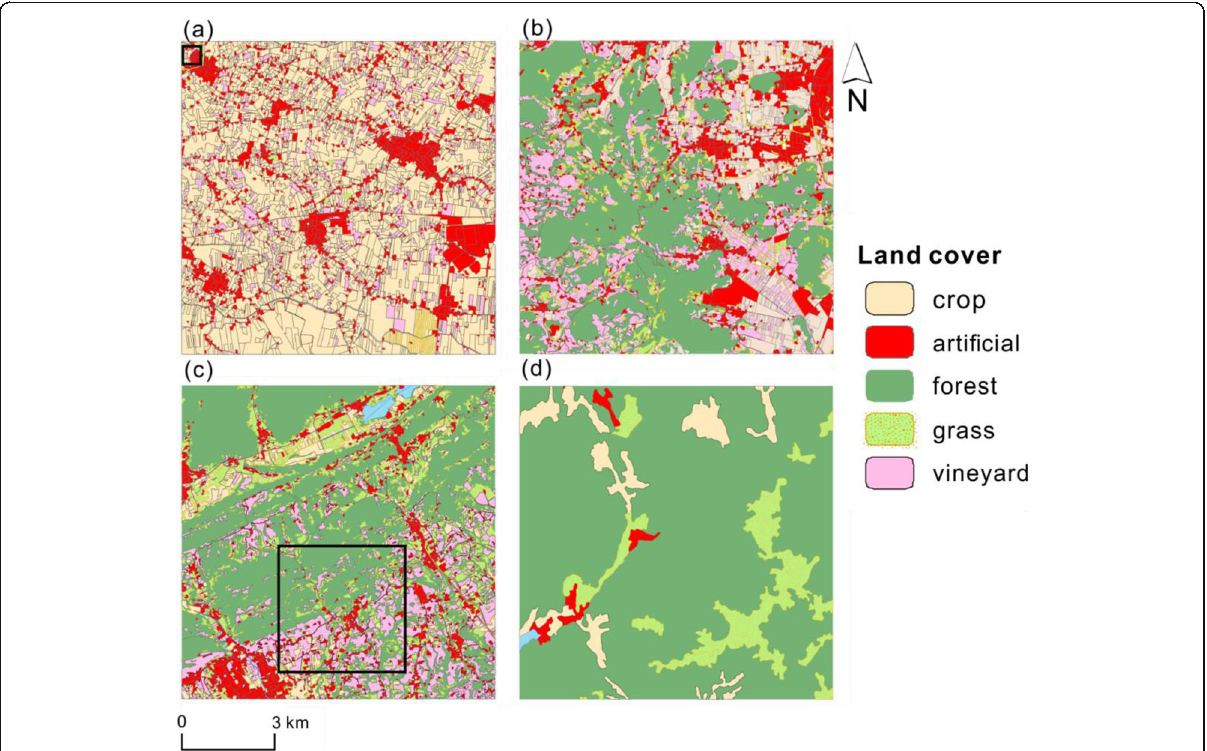
Fig. 4 The land cover classification (Corine Land Cover related to 2012) in the study areas: a floodplain, b plain to hilly, c hilly, d mountain. The black rectangle areas are the case studies in Fig.